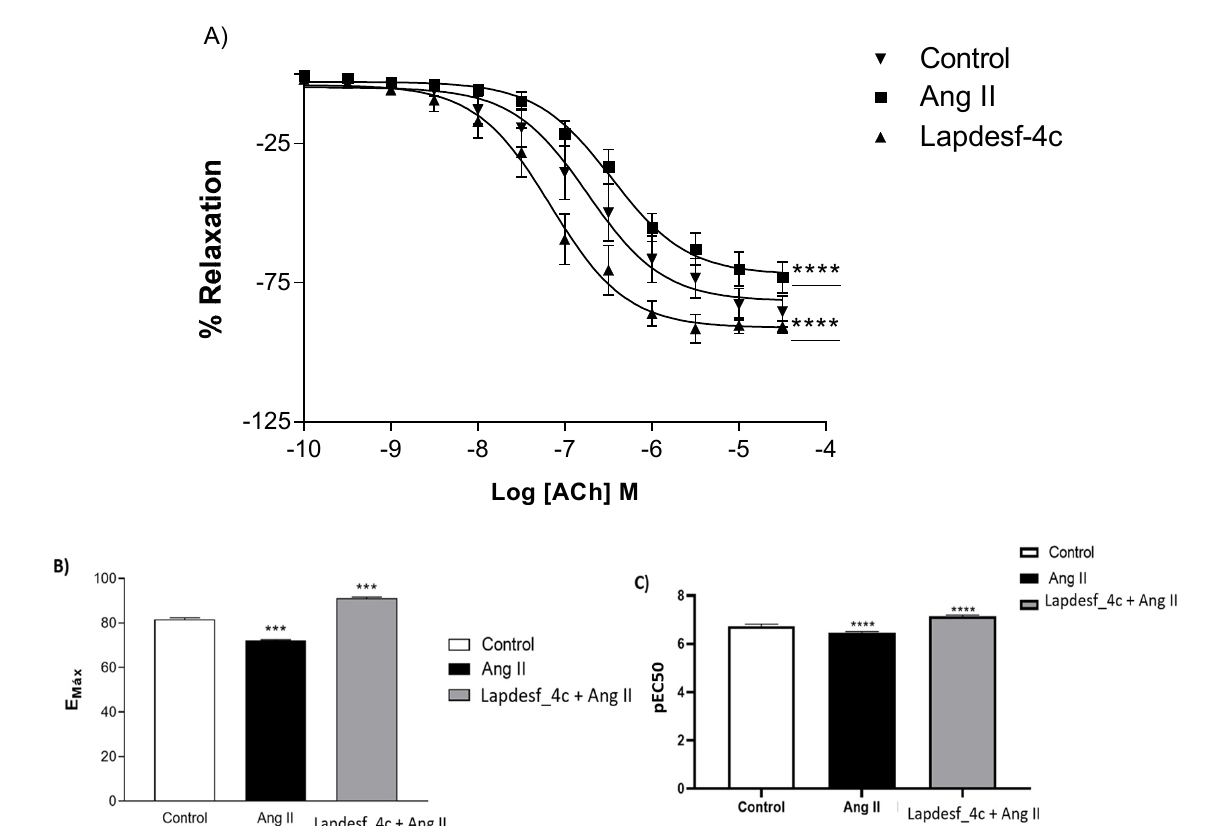
Figure 5. ( A ) Concentration–effect curve for acetylcholine (ACh) in the presence of endothelium (E+). The rings were incubated with Ang II. *** stands for p < 0.0001, which indicates difference between all groups. ( B ) EMax values obtained from the concentration–effect curve of the ACh. **** p < 0.0001 indicates difference between all groups, ( C ) pEC50 values obtained from the concentration–effect curve of the ACh. **** p < 0.0001 indicates difference between all groups.